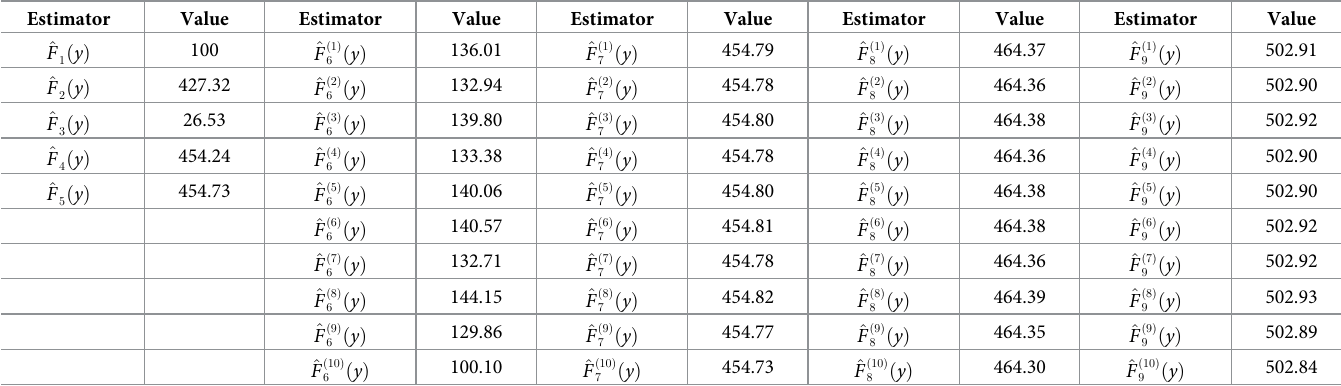
Table 14. PREs of distribution function estimators using Population II.